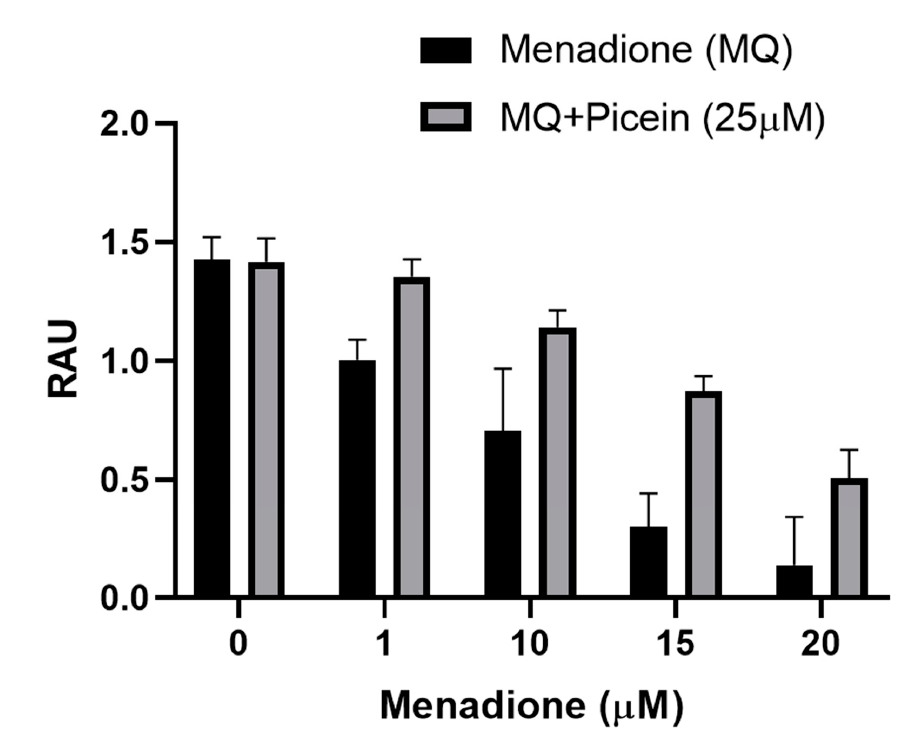
Figure 4. Level of mitochondrial activity (MTT) in human SH-SY5Y neuroblastoma cells after menadione (MQ) treatment and follow-up with picein. The data are presented as mean ± SEM. To give evidence for the statistical variations, factorial ANOVA was applied to examine the p -values for each